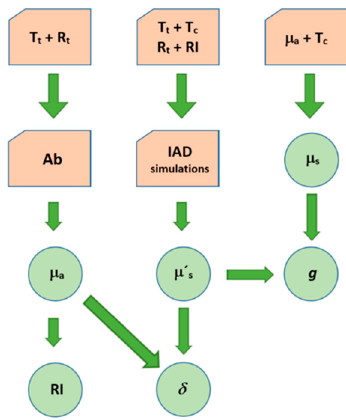
Figure 3. Calculation procedure to obtain the optical properties of a tissue from spectral measurements.